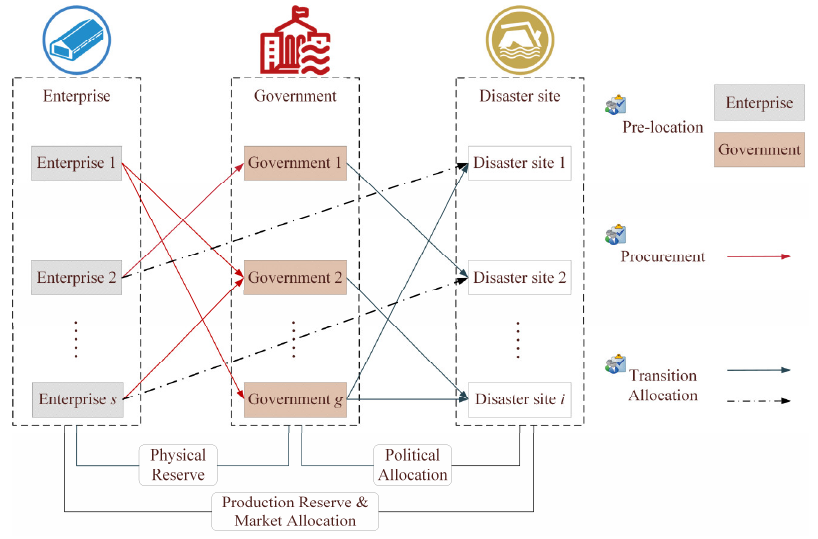
Figure 1. Structure of the emergency relief